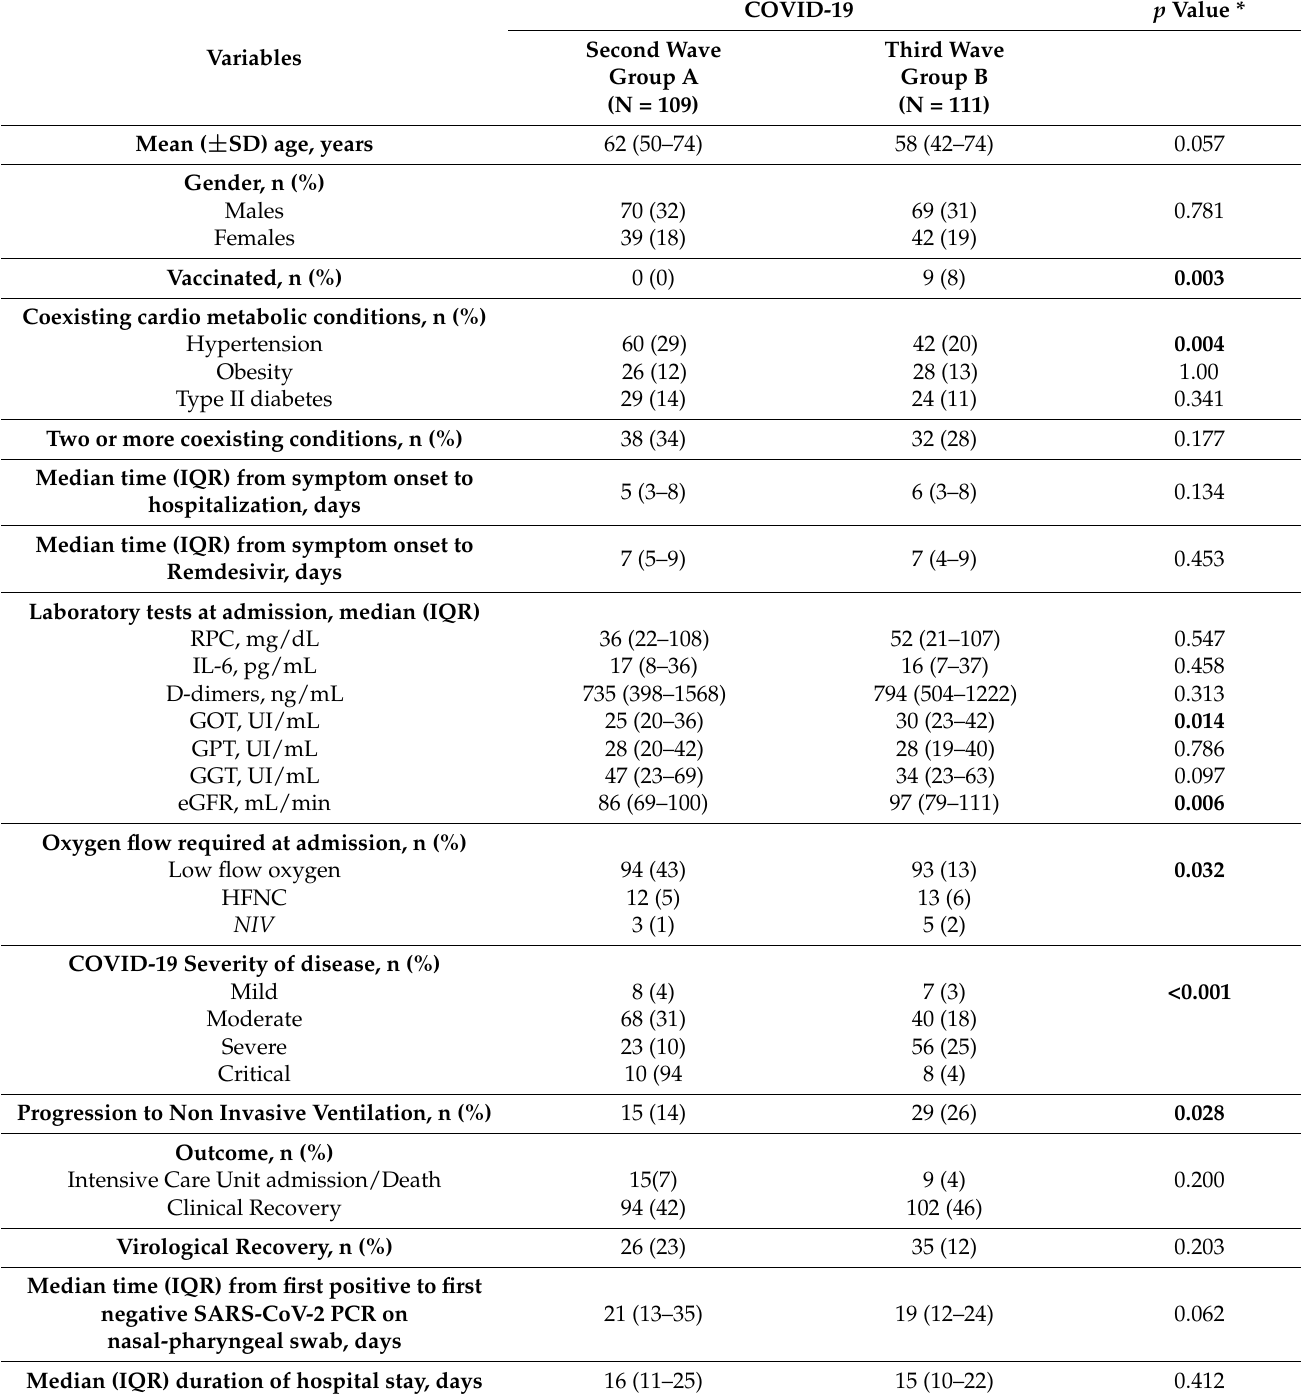
Table 2. General features of patients admitted from 1 September 2020 to 28 February 2021 (Group A) and patients admitted from 1 March to 30 September 2021 (Group B). * A p < 0.05 (bold) was considered as statistically